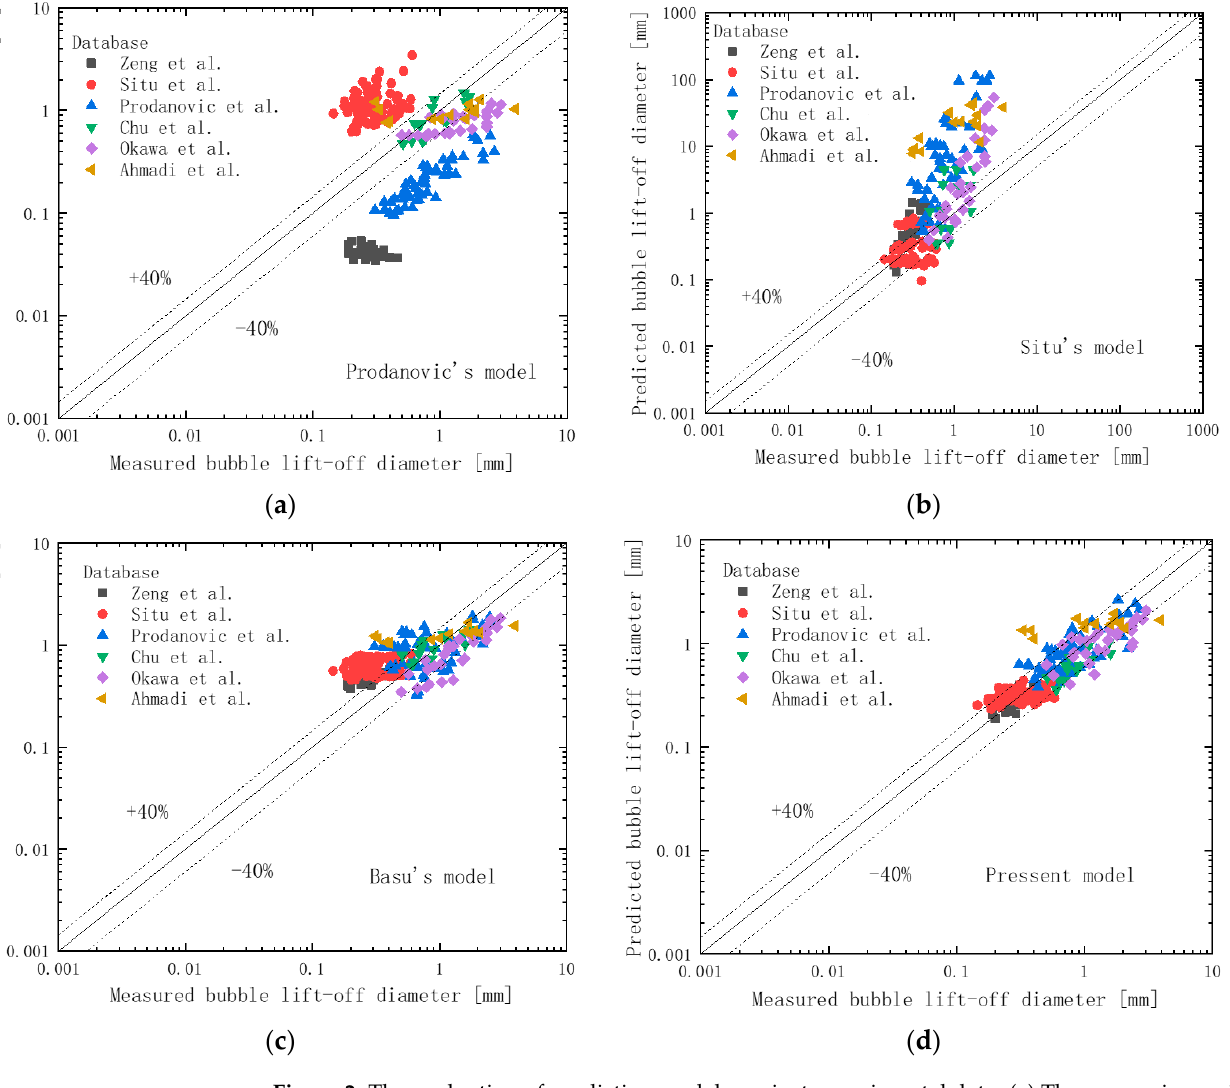
Figure 2. The evaluation of predictive models against experimental data. ( a ) The comparison with Prodanovic’s model; ( b ) The comparison with Situ’s model; ( c ) The comparison with Basu’s model; ( d ) The comparison with the present model [10,17,20,21,24,30]. To concretely assess the performances of these theoretical or empirical models, the comparisons between the predictive models and the experimental data were calculated quantitively. The mean relative error was defined as: